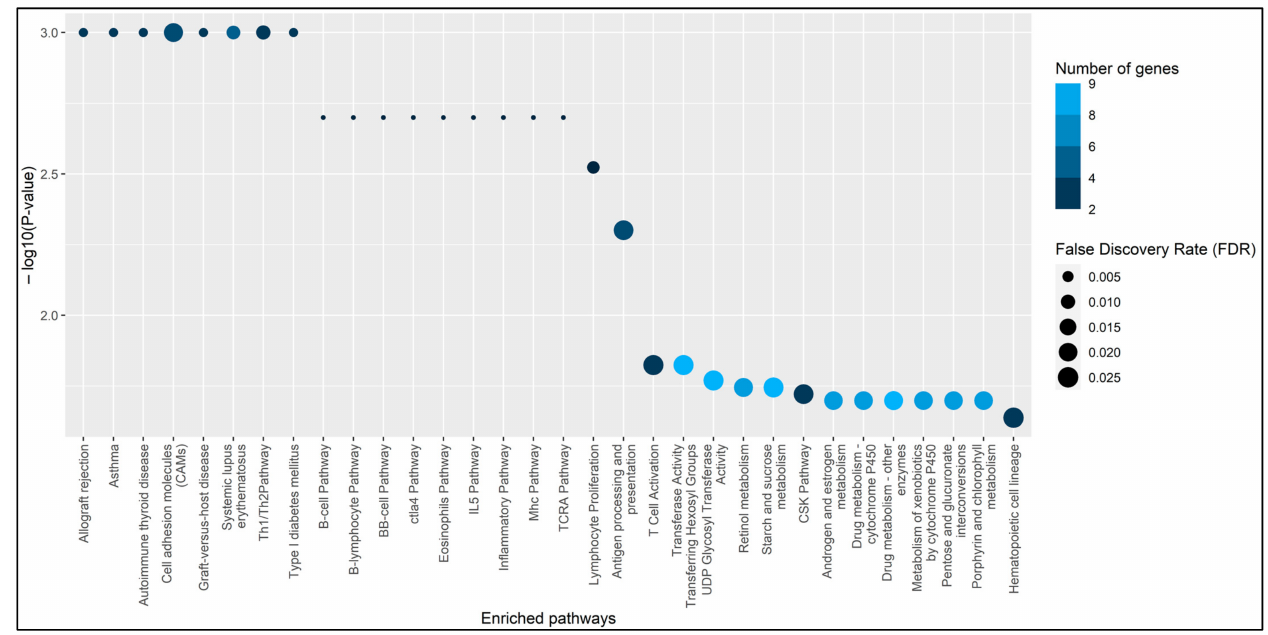
Figure 1. Bubble plot depicting enriched pathways. X -axis represents enriched pathways and Y -axis represents negative log of p -values. The bubble size is proportional to the false discovery rate (FDR) and color represents the number of genes associated with the pathways. The plot was generated using ggplot2 R package